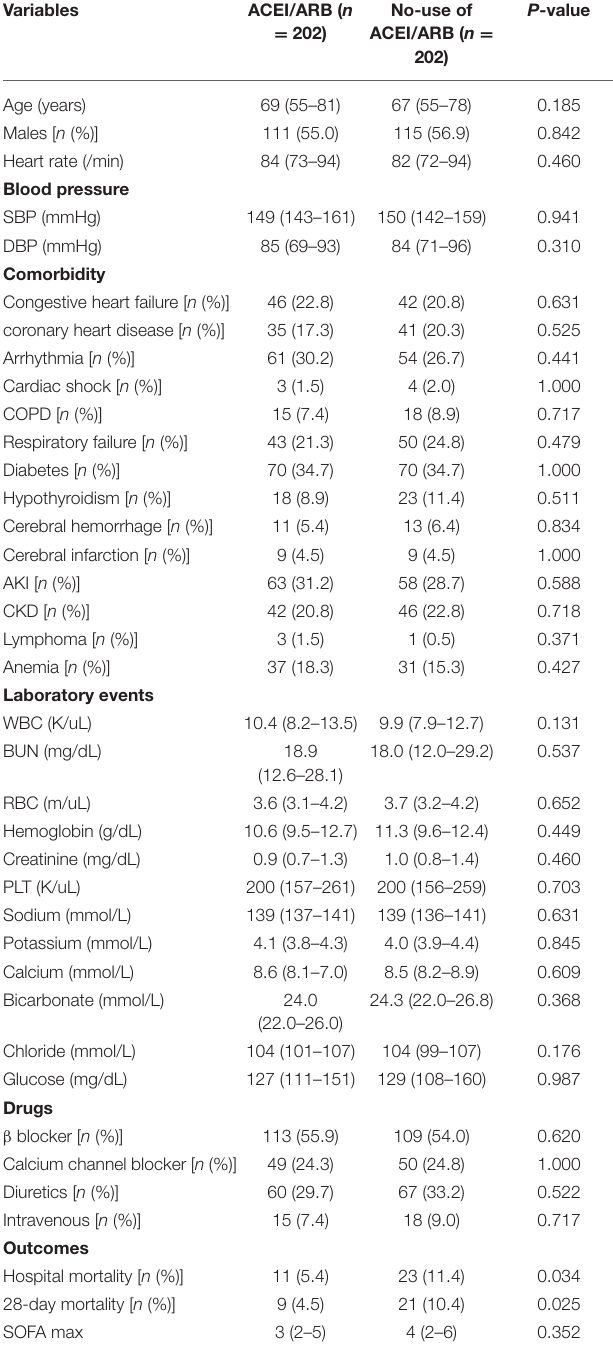
TABLE 3 | Baseline characteristics and clinical outcomes between patients treated with ACEI/ARB and those without ACEI/ARB after propensity score